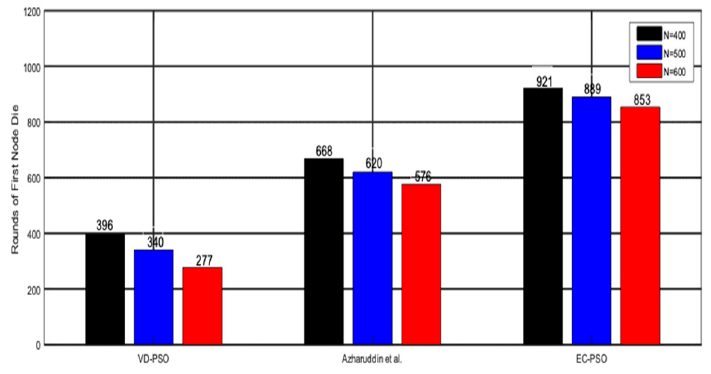
Figure 10. Rounds of first node die.